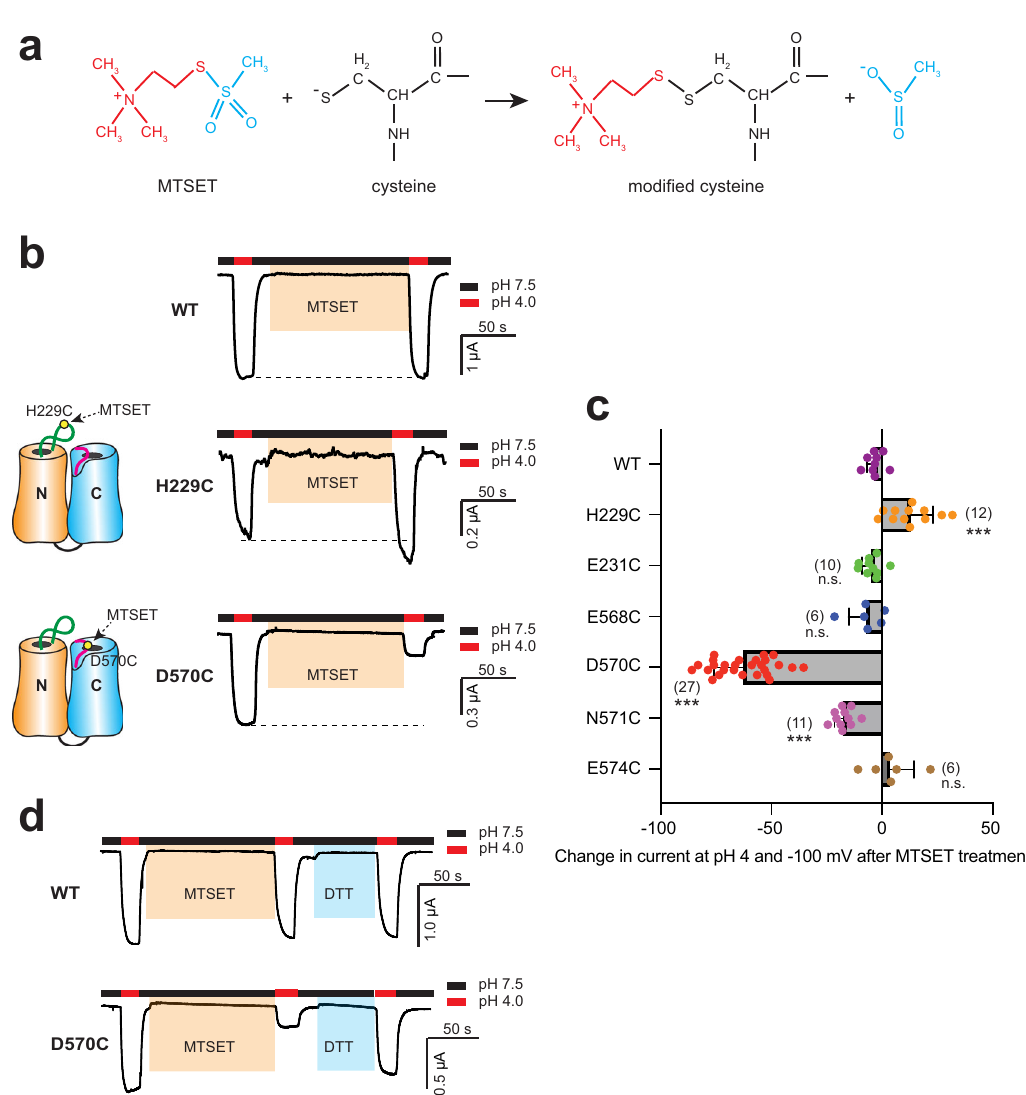
Fig. 6 SCAM con fi rms the roles of H229 and D570 in proton conductance. a Schematic showing the modi fi cation of MTSET on cysteine. b Gap-free recording showing the currents of WT and mutant Otop1 channels at pH 4 before and after 2-min treatment of 1 mM MTSET. Oocytes were clamped at − 60 mV. Dashed lines indicate the current sizes before MTSET treatment. The cartoons on the left demonstrate the reaction of MTSET with the substituted cysteine residues. c The scatter plot and bar graph showing the effect of MTSET treatment on indicated WT and mutant Otop1 channels. Currents at pH 4 after 1 mM MTSET treatment for 2 min are compared with that before treatment. Data in the bar graphs are presented as mean ± SD. Effects on the mutants were compared to that on the WT with Student ’ s t -test (*** P < 0.001, n.s.: no signi fi cance). The numbers of oocytes in each group are indicated in parentheses. d Gap-free recording showing that the application of DTT (50 mM) for 1 min can rescue the effect of MTSET treatment on the D570 mutant. Meanwhile, the WT channel was not affected by DTT D570: E231, R232, E568, N571, and E574. One of the mutants, R232C, abolished channel current (Supplementary Fig. 6).